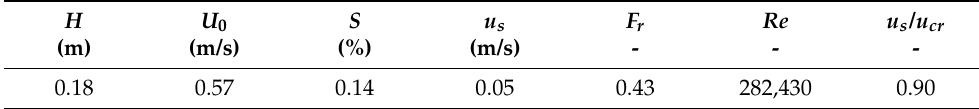
Table 1. Experimental flow and boundary conditions.